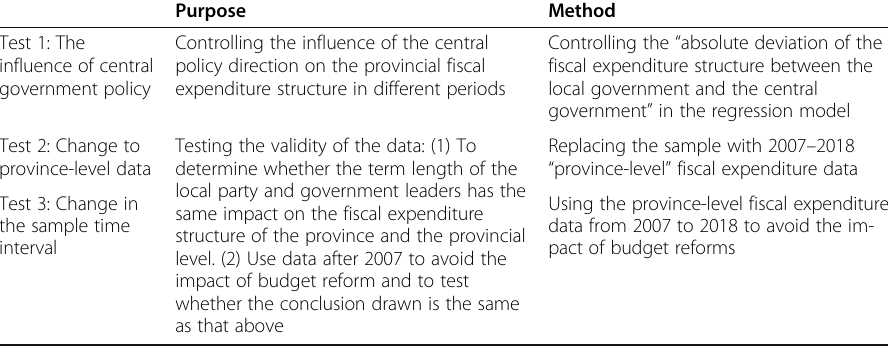
Table 6 Ideas and methods of the robustness test